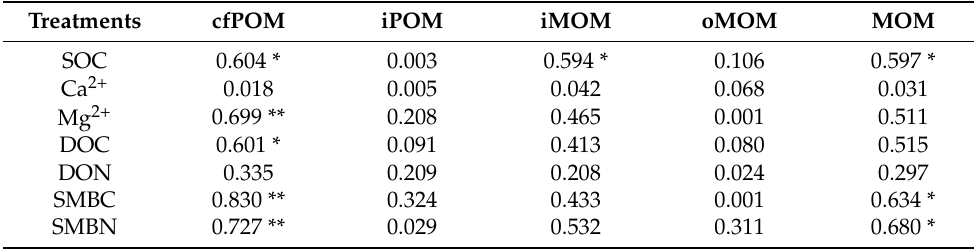
Table 3. Correlation between SIC content and soil